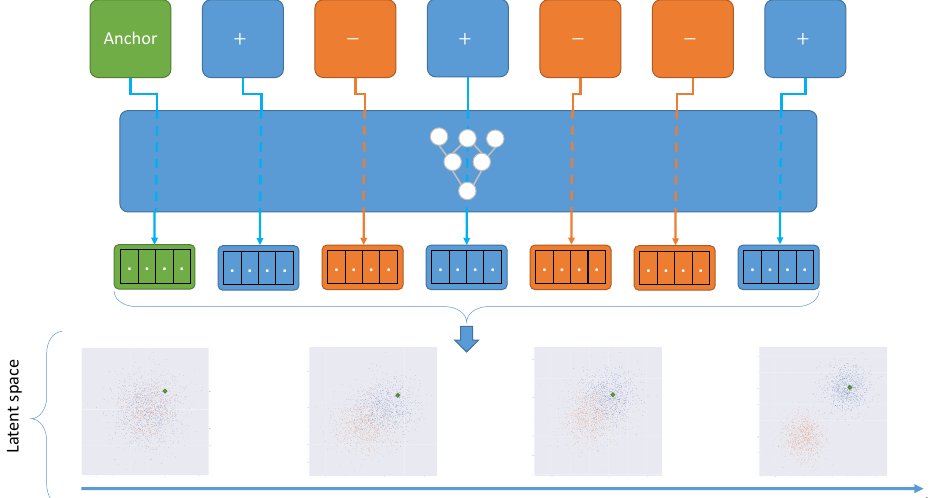
Figure 6. General case of a contrastive learning method. Using anchor and data augmentation methods, the model can learn useful